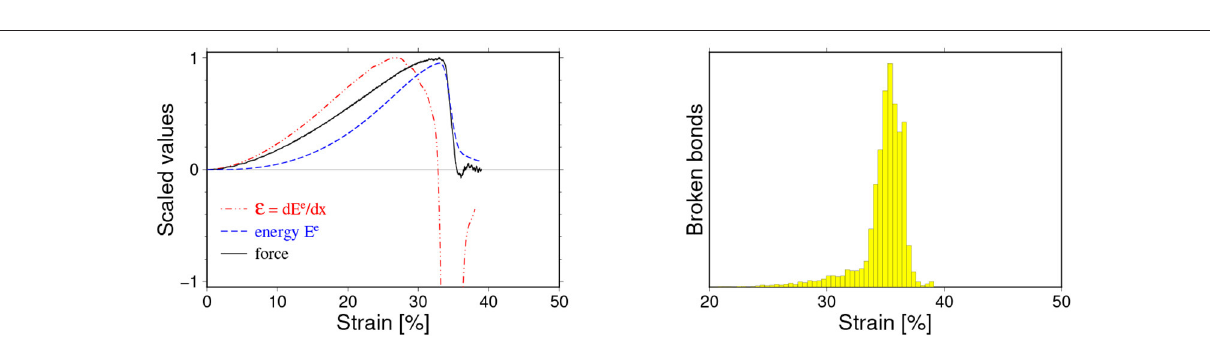
FIGURE 11 | Loading curves for the hyper-elastic breaking mechanisms (see Figure 7 for the description). In this case the fracture has occurred at relatively large deformations but, like in the brittle cases, has been very well-localized around the critical strain x c , and the accumulated elastic energy is almost entirely and quickly released. The particle-particle interaction parameters for this case read: k n = 10 5 N/mm, b d = 0.4